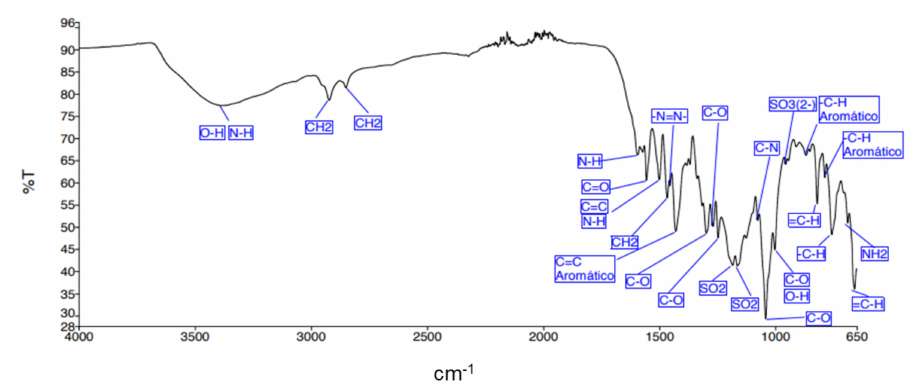
Figure 2. Infrared spectrum of the Bordeaux B dye identifying the bands with their functional groups.